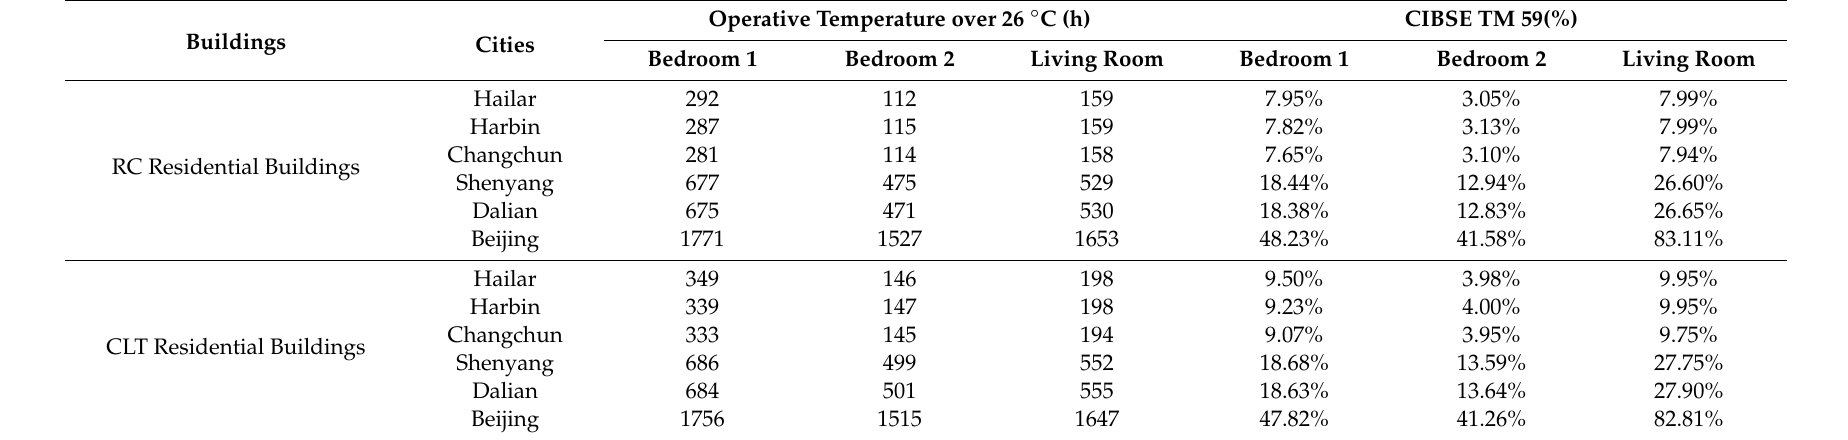
Table 11. Assessment of overheating in RC and CLT buildings (11th floor) based on CIBSE TM